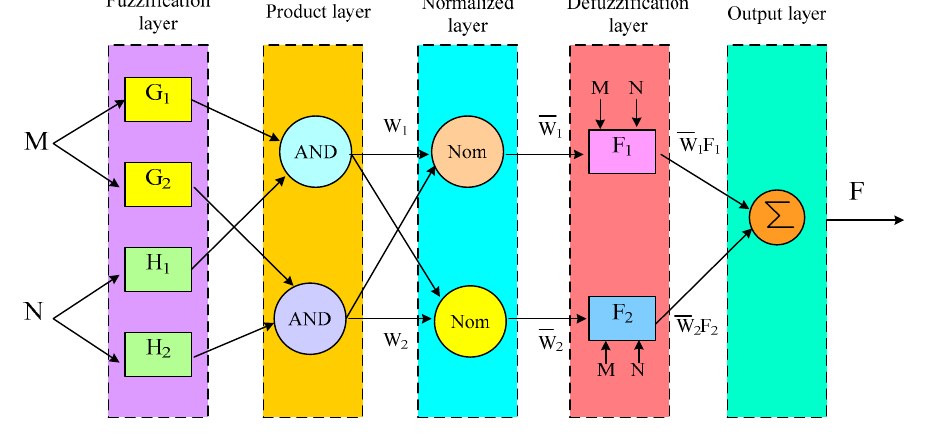
Figure 11. Structure of NFIHC.